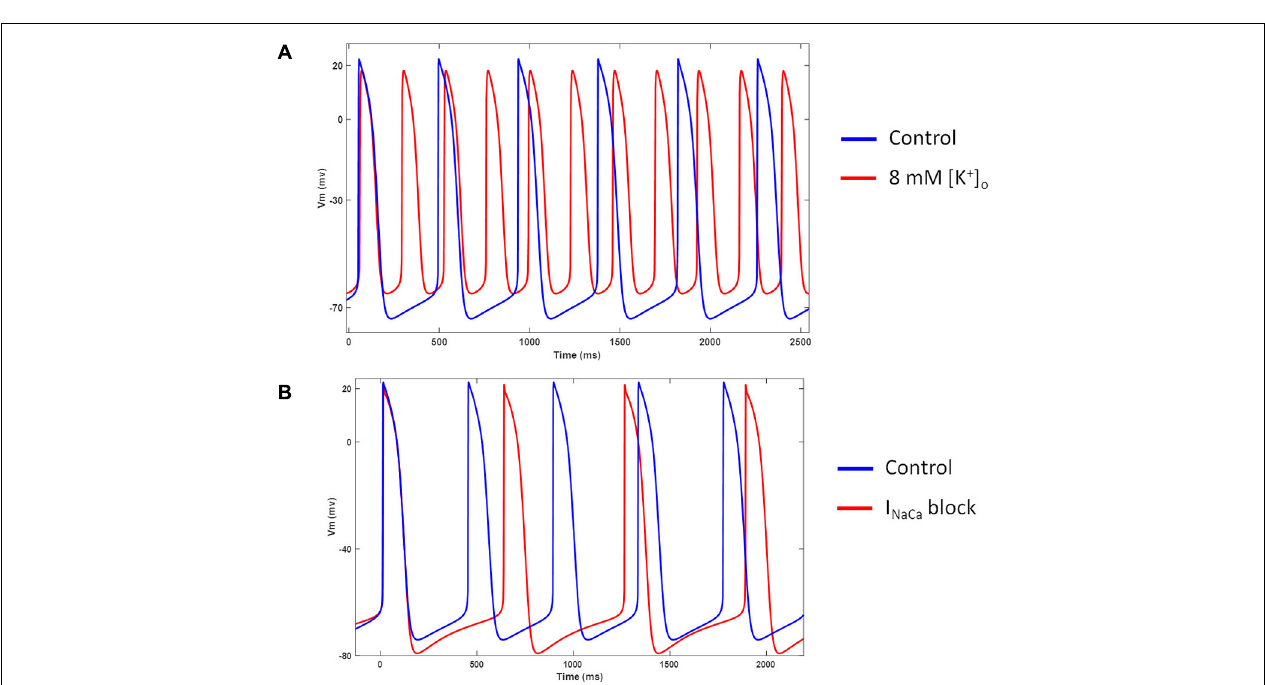
FIGURE 12 | (A) Effect of hyperkalemia ([K + ] o = 8 mM) conditions on model AP and frequency of automaticity. (B) Effect of I NaCa blockade on model AP and frequency of automaticity.